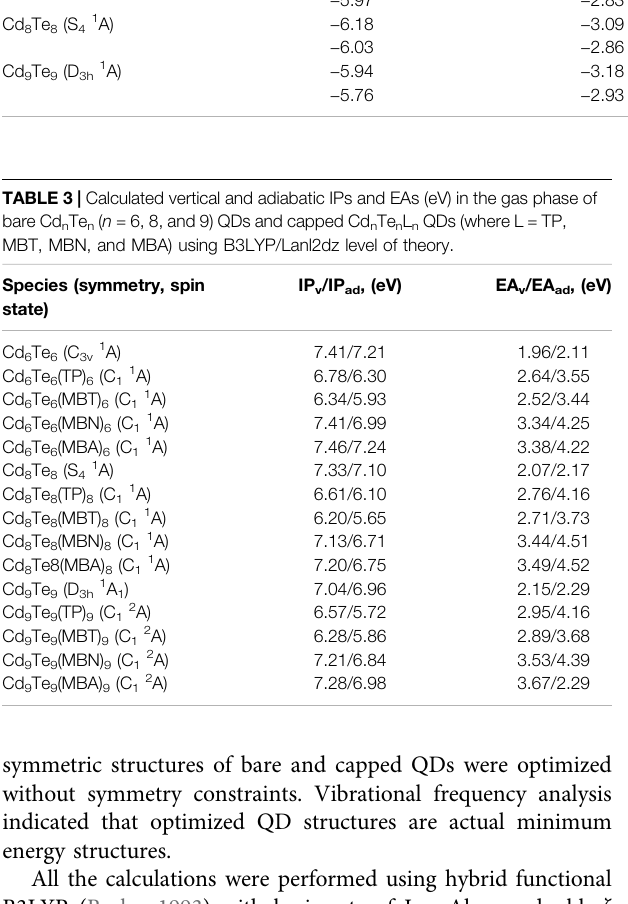
TABLE 2 | Calculated E HOMO energy (eV), E LUMO energy (eV), HOMO-LUMO gaps (eV), excitation energies ( E max ) (eV), and maximum absorption wavelengths ( λ max ) (nm), of the excited states with maximum oscillator strength of bare Cd n Te n ( n (cid:1) 6, 8, and 9) QDs in the gas phase and toluene with TDB3LYP/Lanl2dz approach. E LUMO , Gap, (eV) Species (symmetry, E HOMO , eV (gas eV (gas spin state) phase; toluene) phase; toluene)